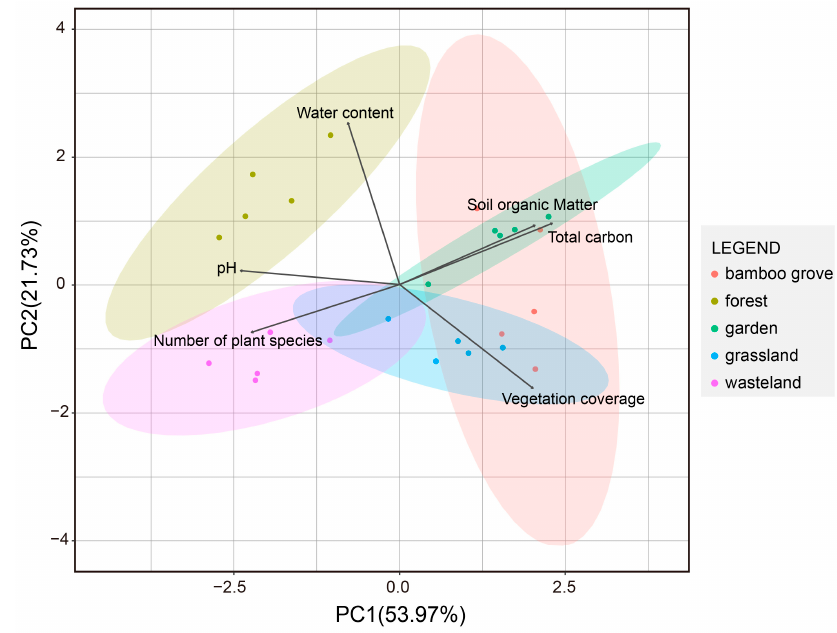
Figure 2. The PCA biplot on soil properties and vegetation.